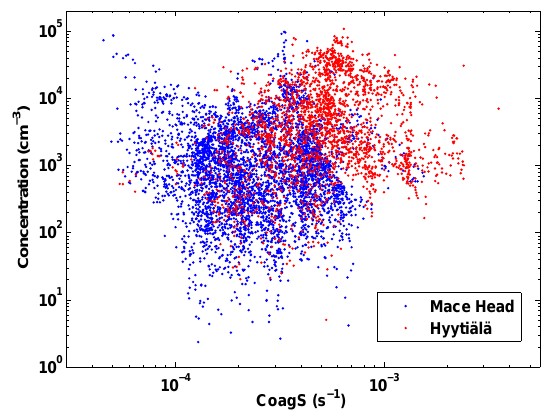
Fig. 1. Diurnal variation of nano-CN (1.3–3nm) concentration in Hyyti¨al¨a and Mace Head. The solid line is at the median of 15min mean concentrations during the whole measurement period, and the dashed lines indicate 5%- and 95%-percentiles.